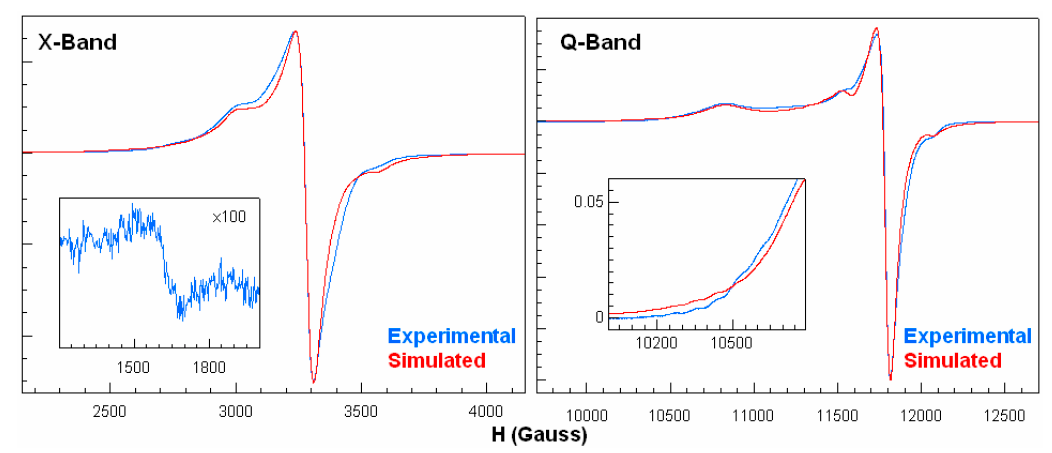
Figure 11. Experimental and simulated X- band (υ = 9.49 GHz) and Q - band (υ = 34.06 GHz) EPR spectra of 2 at room